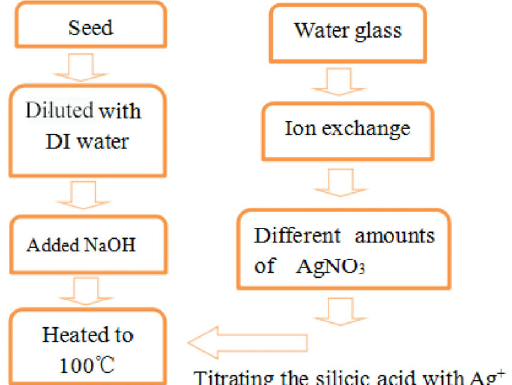
Fig. 1 The experimental flow chart of modified